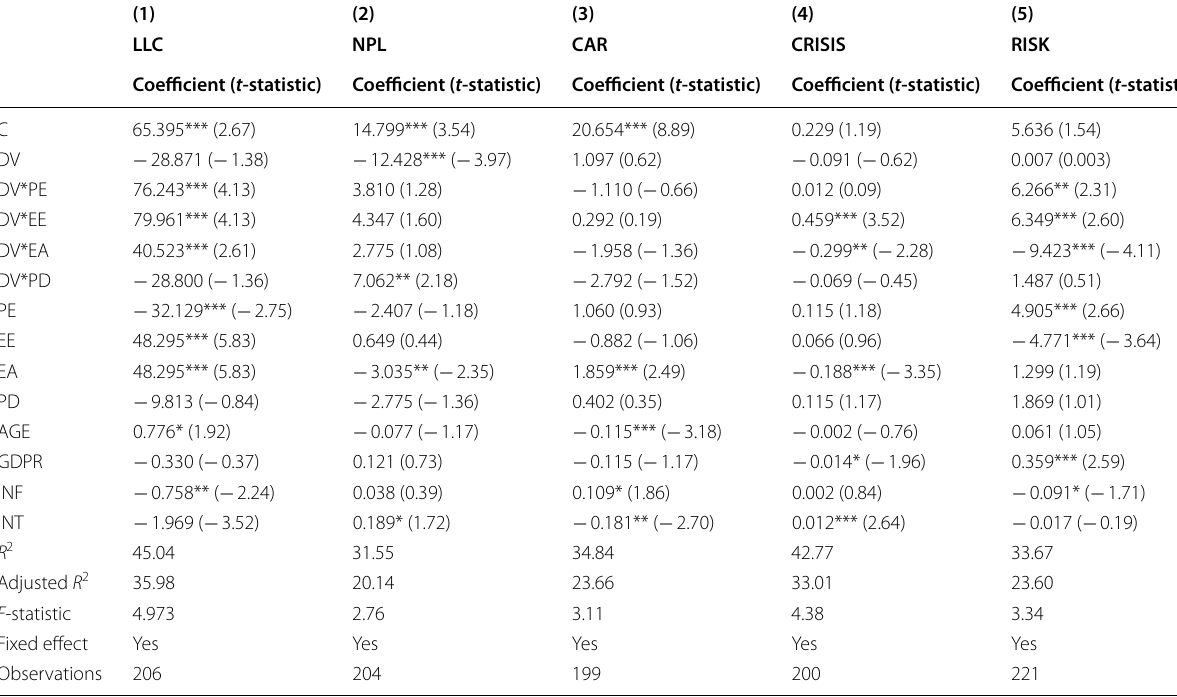
The results in this table are estimated using fixed-effect regression. Only period fixed effect was applied ***, **, * represent significance at 1%, 5%,